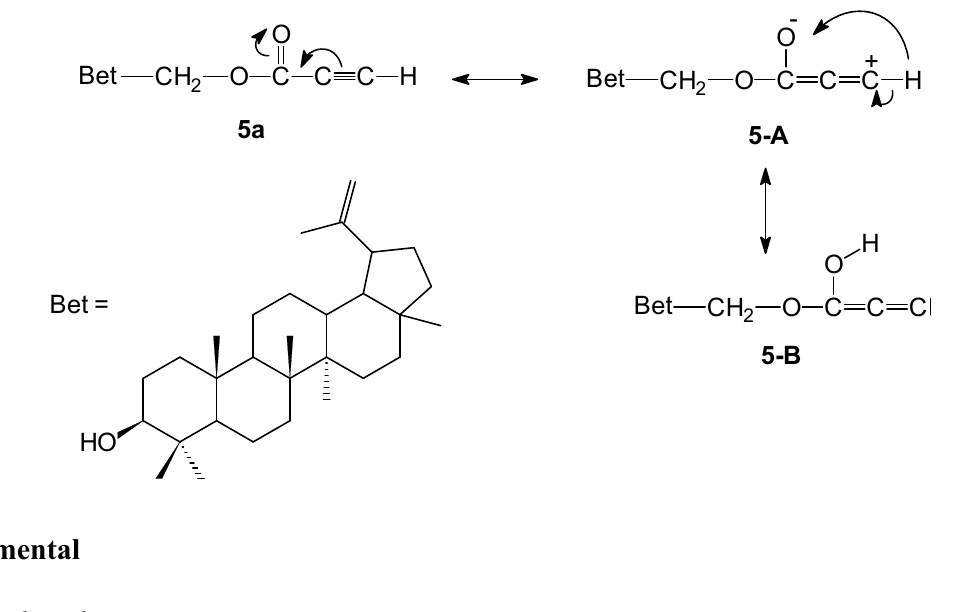
Figure 3. Proposed mesomeric structures of propynoyl pharmacophore of 28- O - propynoylbetulin ( 5a